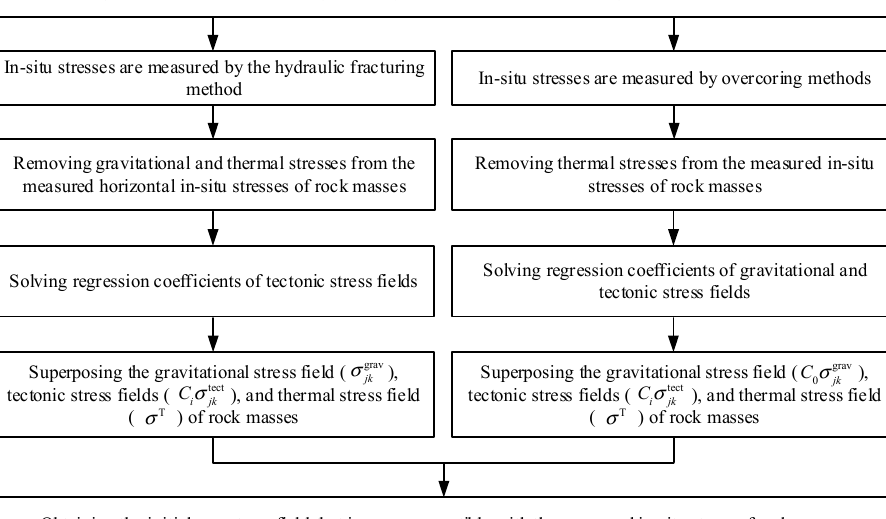
Figure 4. The workflow for a back analysis of the initial geo-stress field of rock masses considering geo-temperature.